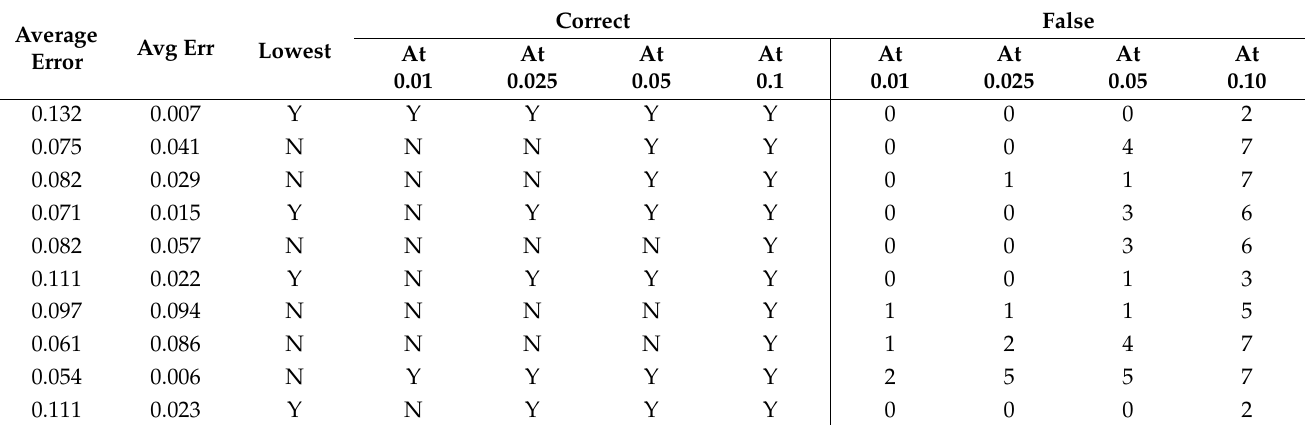
Table 10. Set 3, trials 21–30 summary data (actual PR